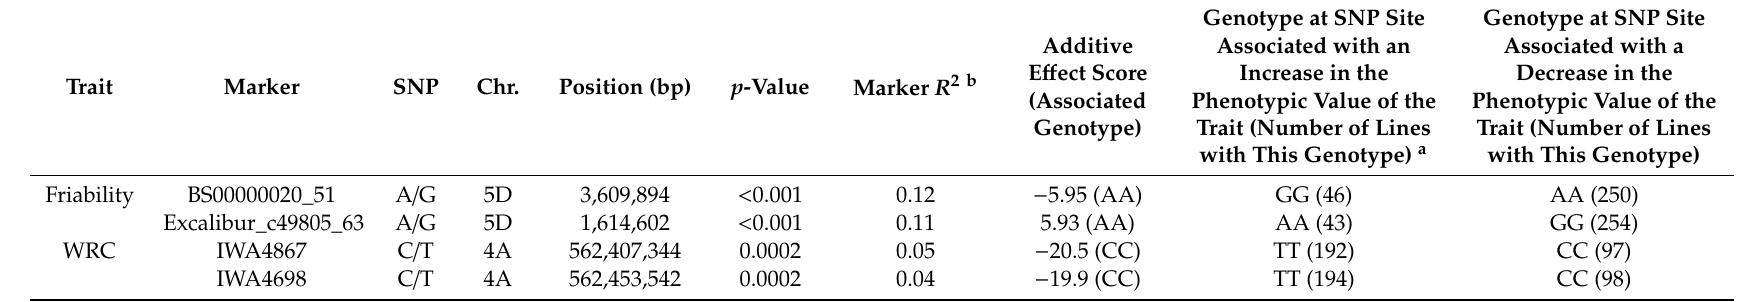
Table 1. Trait-associated SNPs and their annotations.